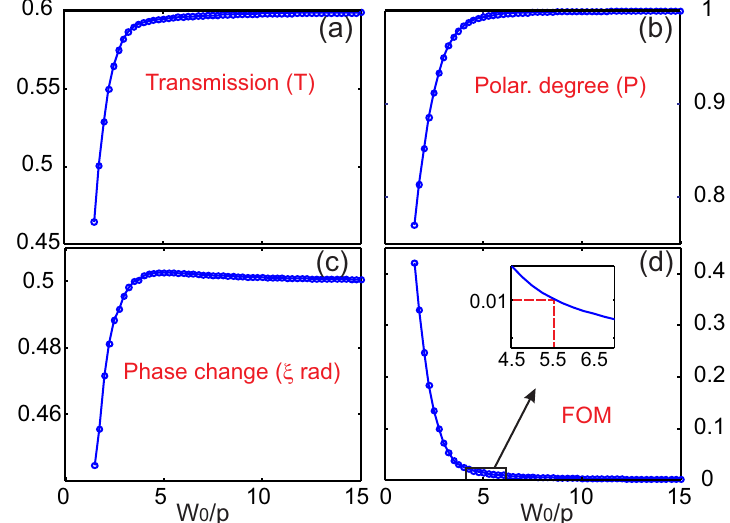
Figure 4. Same study as in Figure 3, but for the quarter-wave plate operating at λ = 1.182 p